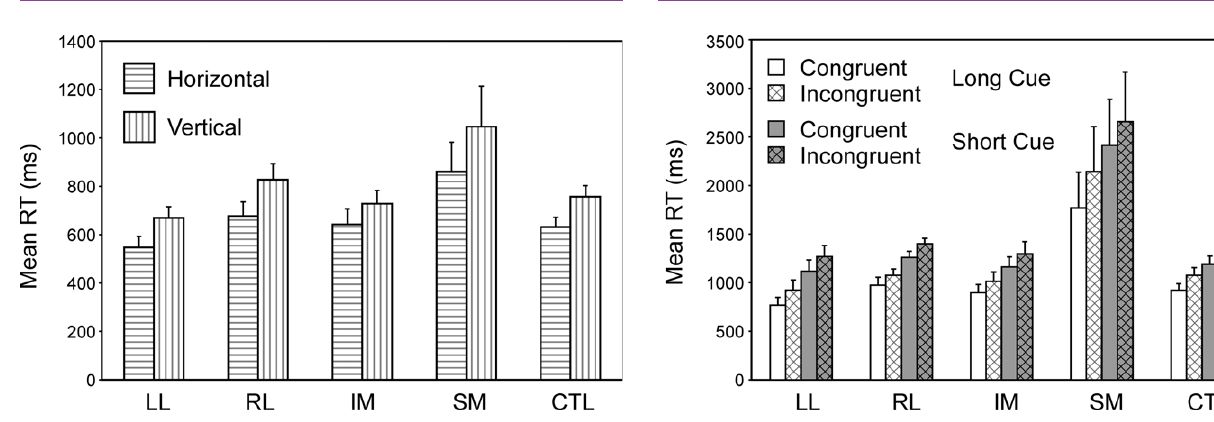
Figure 5. Effects of congruency. Mean reaction times and standard errors for the four patient groups and the controls on Congruent and Incongruent trials in the Long Cue and Short Cue task conditions.